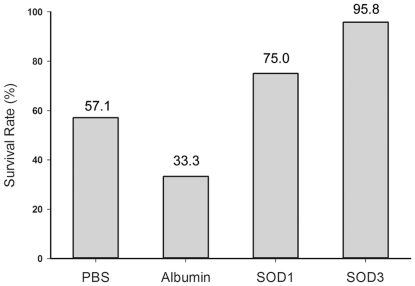
Effects of aerosolized CuZn-SOD and rhEC-SOD on survival after 72 h of hyperoxia.Phosphate-buffered saline (PBS) inhalation was used as the hyperoxia-induced lung injury control group. The three treatment groups were Albumin, SOD1 (CuZn-SOD), and SOD3 (rhEC-SOD) (n = 24 in each group). The albumin treated group was added as a non-SOD inhalation control group.